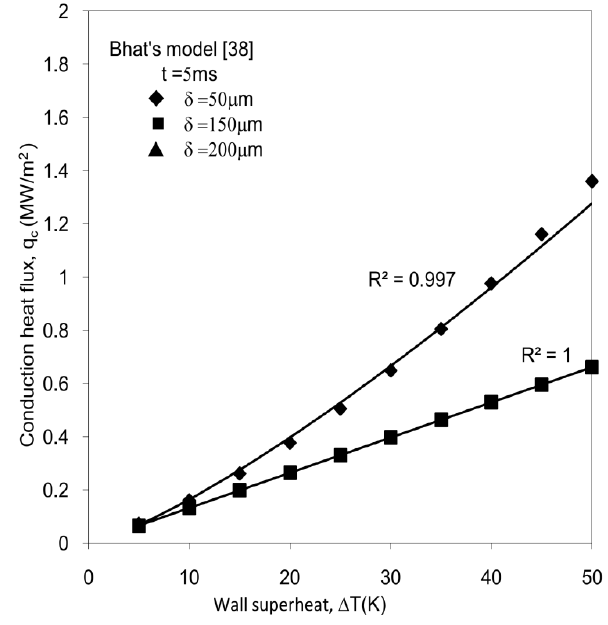
Figure 1. Effect of the wall superheat on conduction heat flux for different macrolayer